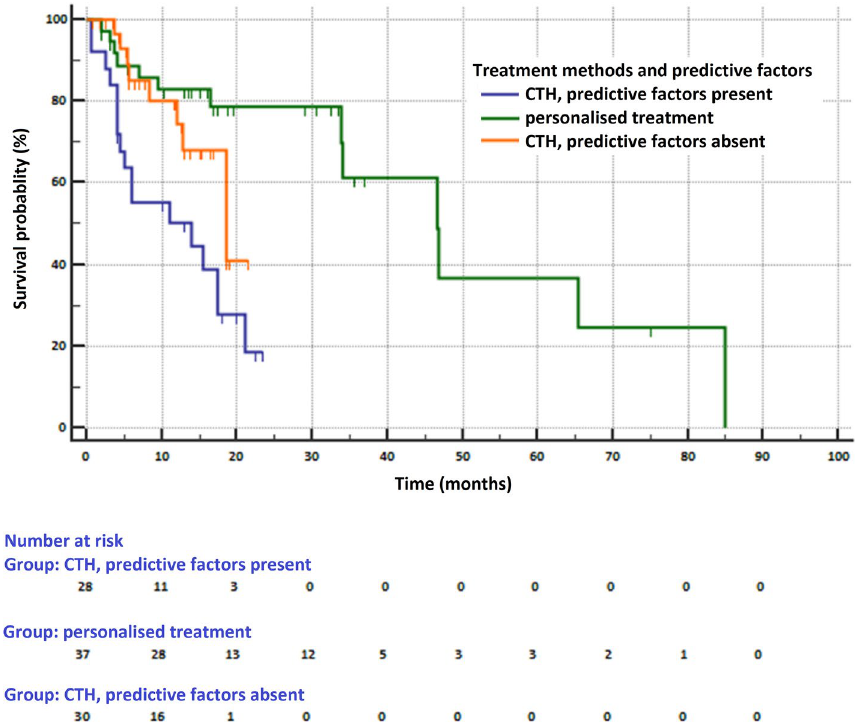
Figure 2. Survival of patients depending on the presence of predictive factors (mutations in the EGFR gene, rearrangements of ALK and ROS1 genes, PD-L1 expression) and the type of treatment (MedCalc Statistical Software version 18.11.6, https:// www. medca lc. org).